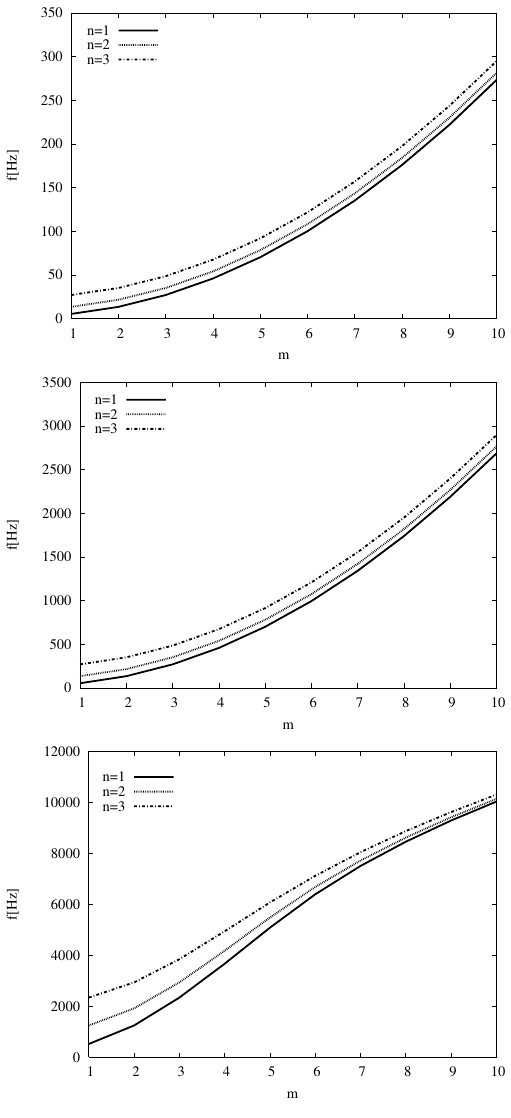
Figure 17: Second benchmark, simply supported cylinder made of aluminium alloy with thickness ratios R α /h=1000 (top), R α /h=100 (middle) and R α /h=10 (bottom). First (I) 3D frequencies versus half- wave numbers m (values around that for minimum frequency) and n (from 1 to 3).